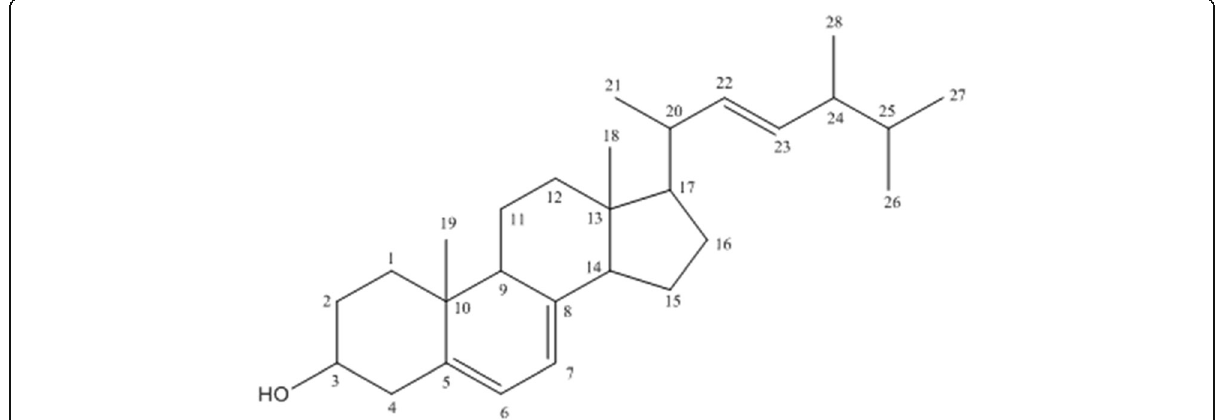
Fig. 1 Structure of ergosterol confirmed by 13 C, 1 H RMN and GC-EI-MS